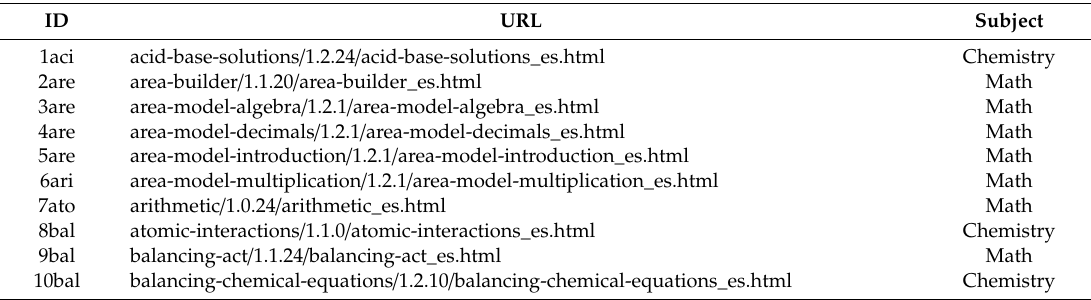
Table 1. Serious games were selected for evaluation.